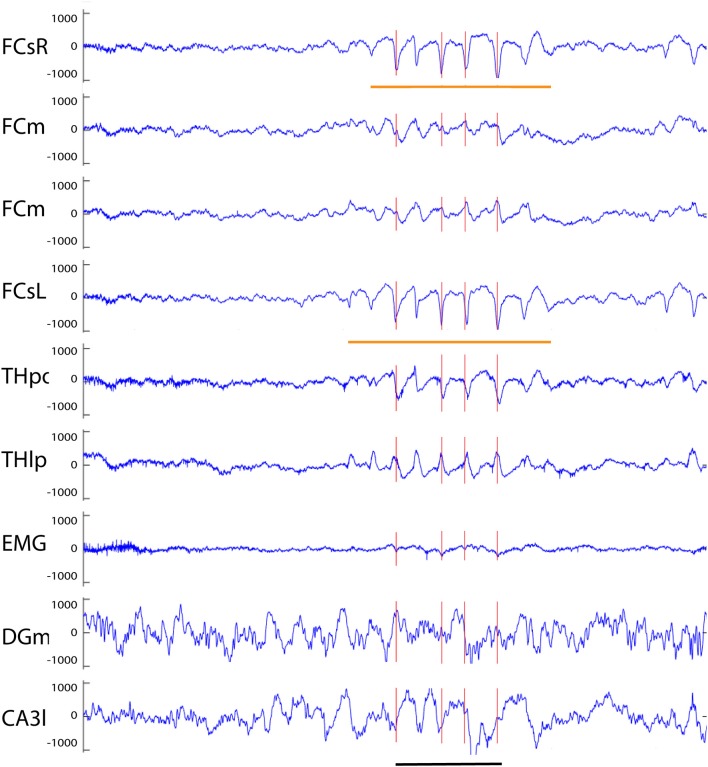
Example of a spike-wave discharge recorded from an APP/PS1 mouse. A prominent complex with surface-negative spikes and surface-positive waves at 8 Hz can been seen in full synchrony on both frontal screw channels (orange horizontal lines). Oscillations of opposite polarity can be seen on both medial frontal channels, and spike of same and reverse polarity on thalamic THpo and THlp channels, respectively, all in full synchrony with the spikes recorded on the cortical surface. The red vertical lines indicate spikes exceeding the 6 SD threshold on the FCsR reference channel. Channel abbreviations as above, except CA3l, CA3 stratum lucidum. Scale bar = 500 ms.